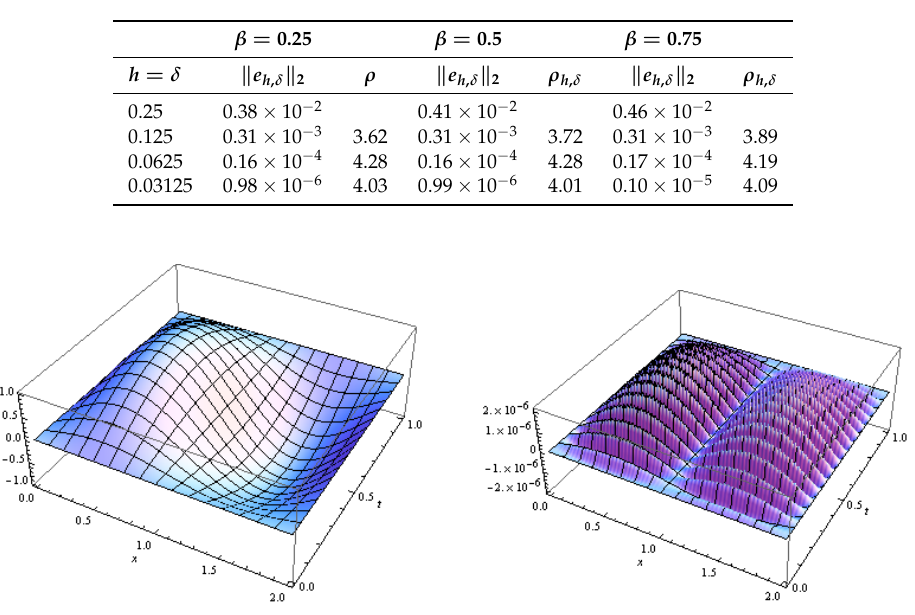
Table 5. Test 3: The L 2 -norm of the error and the numerical convergence order ρ h , δ as a function of the time step δ and the space step h for different values of the order β of the fractional derivative.